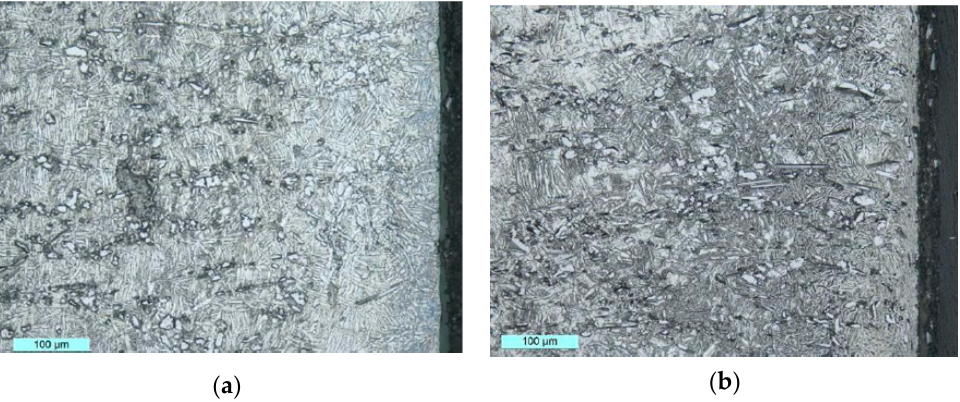
Figure 7. Changes in microstructure: ( a ) v s = 25 m/s, v w = 300 mm/s, a p = 0.3 mm; ( b ) v s = 20 m/s, vw = 300 mm/s, a p = 1.0 mm (v s = cutting speed, v w = speed of the workpiece, and a p = cutting depth) [62] .